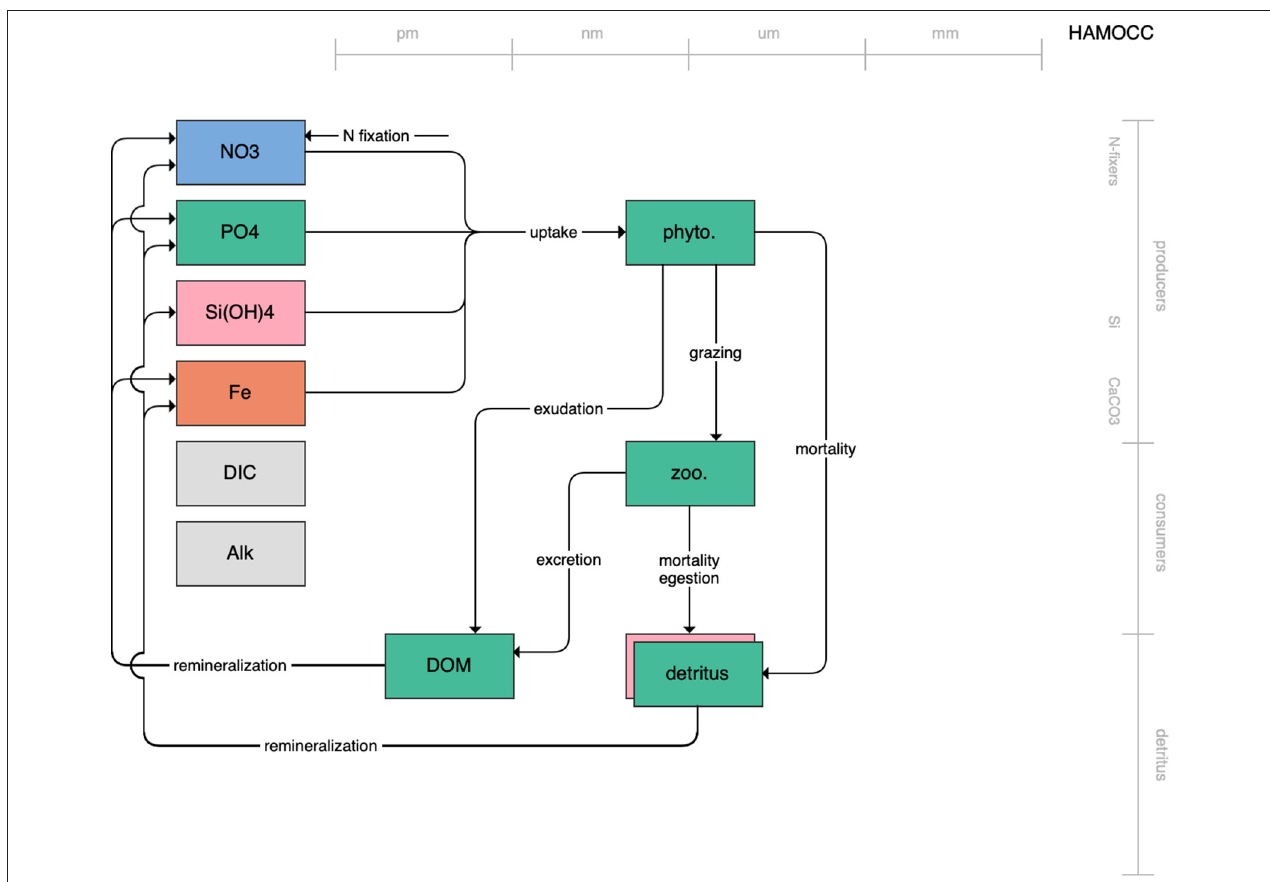
FIGURE 5 | Schematic for the HAMOCC model. See Figure 1 caption for